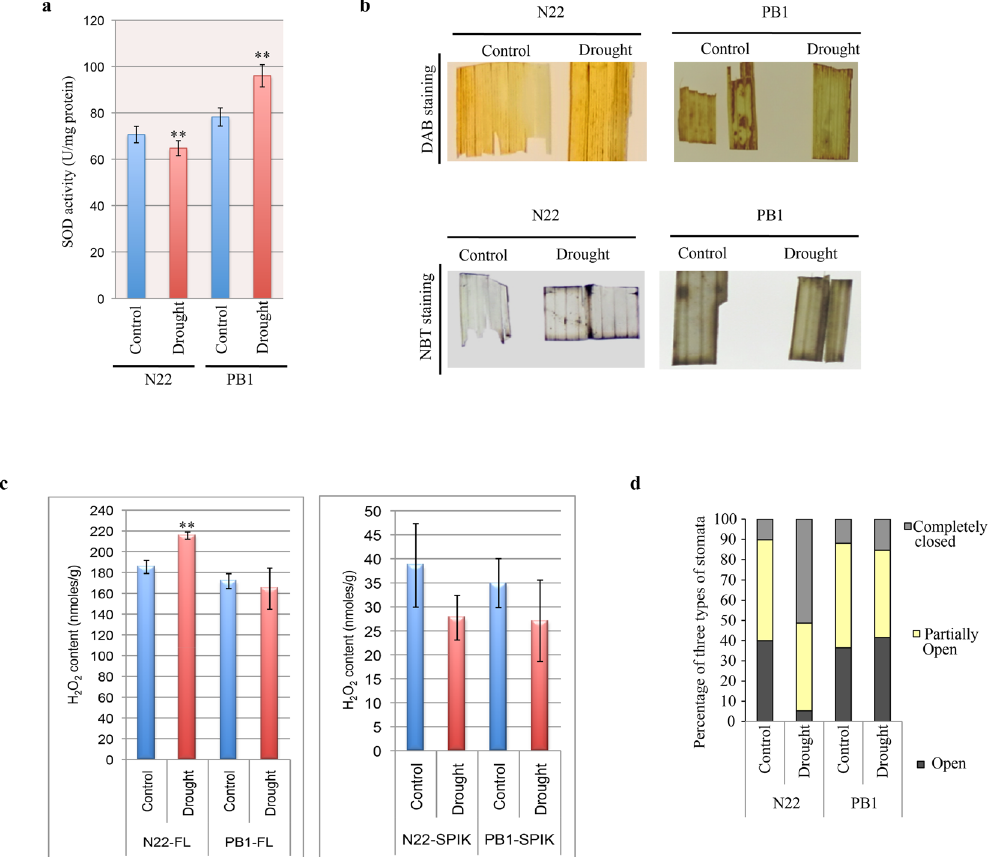
Figure 7. Drought leads to the differential ROS accumulation in rice cultivars. ( a ) SOD activity assay in the flag leaves of N22 and PB1 under control and drought conditions by monitoring the inhibition of the photochemical reduction of NBT. The data represents the mean value of seven biological and three technical replicates each. The asterisks indicate a significant difference between the indicated samples {two-tailed students t-test, P < 0.05 ( * ), P < 0.005 ( ** ), P < 0.001 ( *** )}. ( b ) The histochemical staining for detecting the accumulation of H 2 O 2 by DAB and superoxide ions by NBT in the flag leaf segments of control and drought stressed N22 and PB1. ( c ) The quantitative estimation of H 2 O 2 in flag leaf (FL) and spikelet (SPIK) of N22 and PB1 under drought stress. The data represents the content on fresh weight basis and eight biological replicates were analyzed for each sample. The asterisks indicate a significant difference between the indicated samples {two-tailed students t-test, P < 0.05 ( * ), P < 0.005 ( ** ), P < 0.001 ( *** )}. ( d ) The percentage of three types of stomata (open, partially open and completely closed) in the flag leaves of N22 and PB1 under control and drought stress conditions (n {no. of stomata}; n = 293 for N22 control, n = 265 for N22 drought, n = 277 for PB1 control and n = 287 for PB1